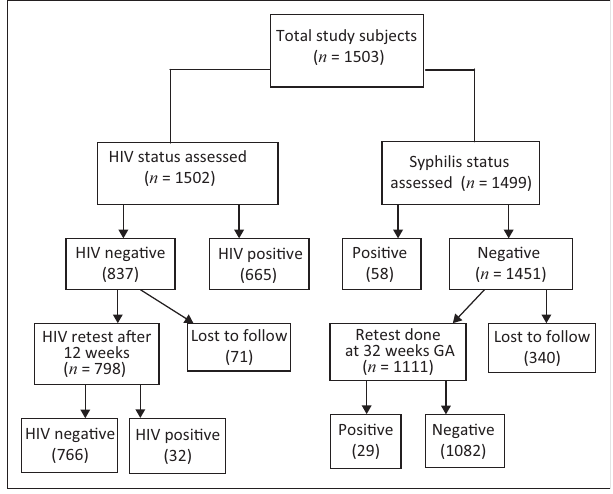
FIGURE 1 : Flow diagram of study subjects at different stages of